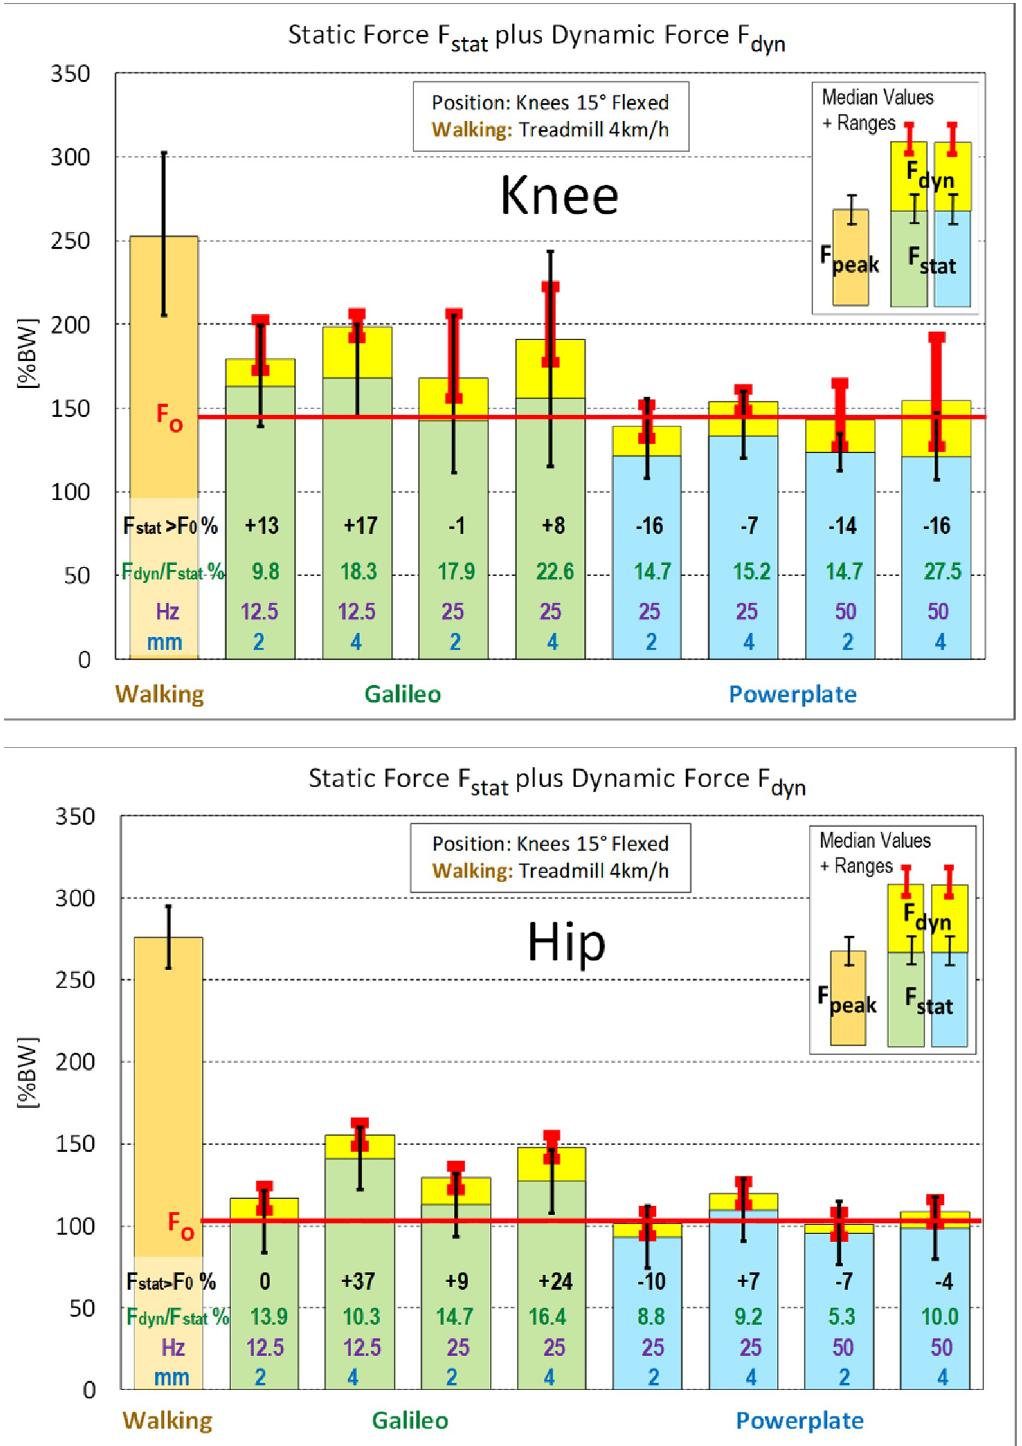
Fig 8. Static plus dynamic joint forces on Galileo and Powerplate platforms, compared to peak forces during walking. Body position: knees 15˚ flexed. Orange columns = peak force F peak during walking. Green/blue columns = median plus (black) range of static force F stat (with vibrations). Top yellow boxes = median plus (red) range of dynamic force F dyn (values as in Fig 5). ‘F 0 ’ = static force in same position without vibration. ‘F stat > F 0 %’ = Excess of F stat above F 0 as a percent of F 0 . ‘F dyn /F stat %’ = dynamic force F dyn as a percent of static force F stat . ‘Hz’ = platform frequency. ‘mm’ = platform stroke.